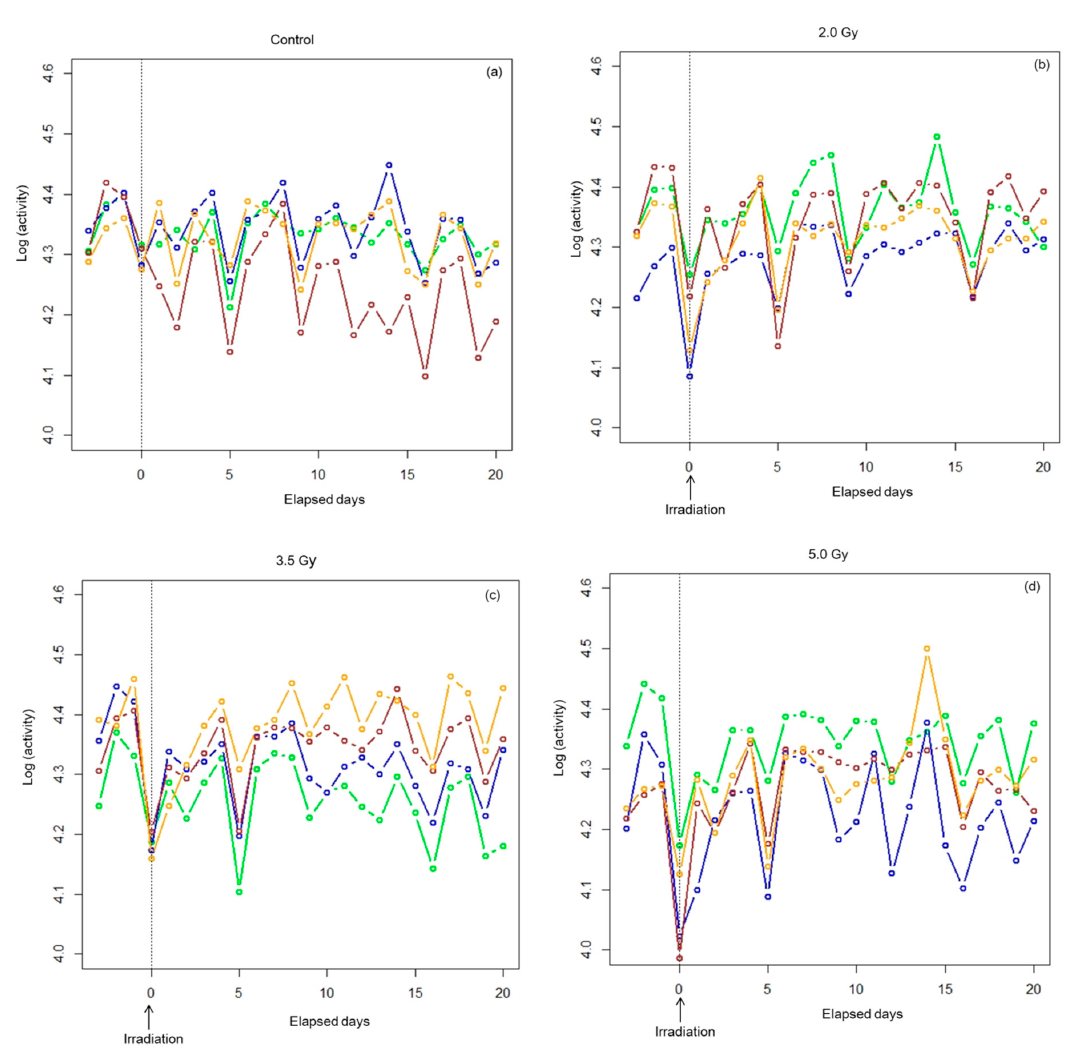
Figure 2. Daily activity of each of the four rats belonging to the four groups. The vertical axis shows the logarithm of daily activity (number of nocturnal movements) and the horizontal axis shows elapsed time in days relative to the day of irradiation (indicated by arrows): ( a ) the control group, ( b ) 2.0 Gy group, ( c ) 3.5 Gy group, and ( d ) 5.0 Gy group.